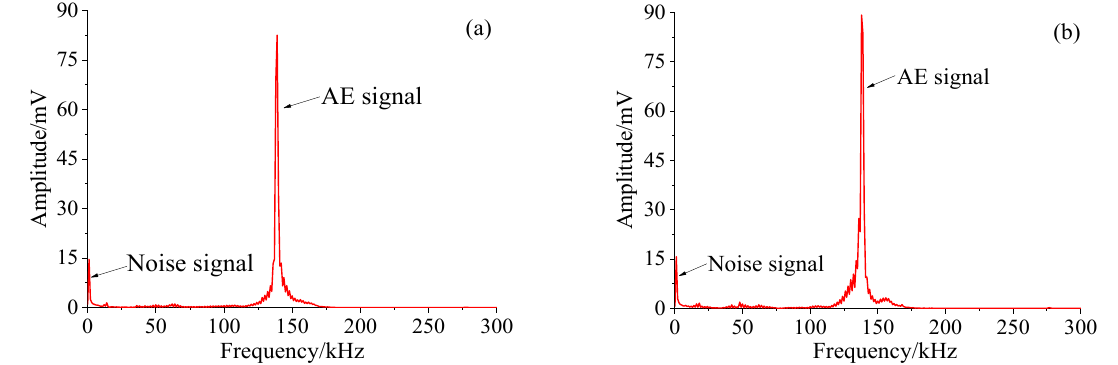
Figure 16. Frequency spectrum of AE by the AW method: ( a ) Excitation position is 50 mm; ( b ) excitation position is 150